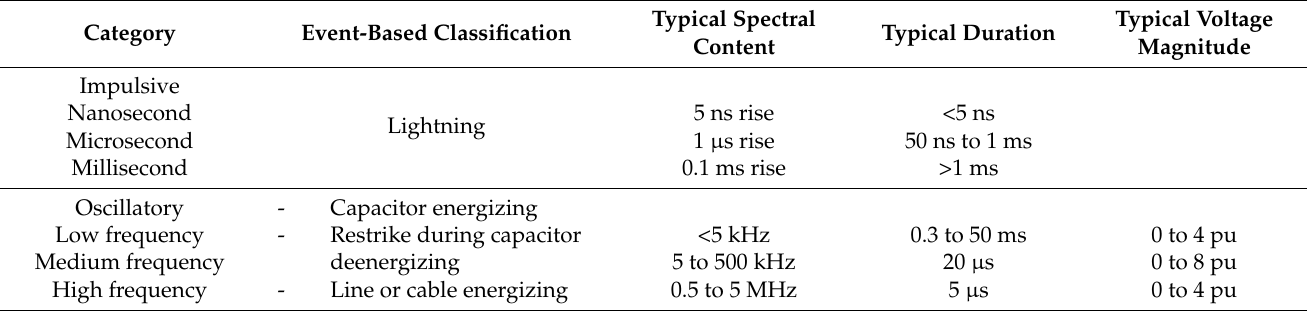
Table 3. Characteristics of transient